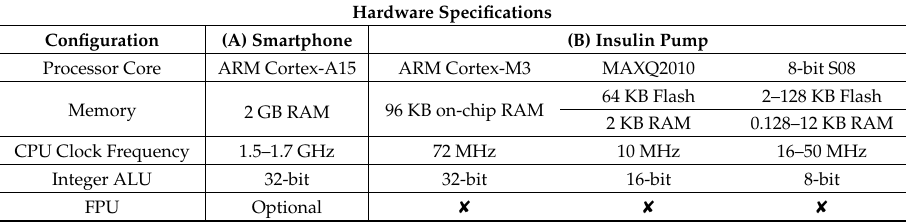
Table 1. Hardware specifications for various AP (artificial pancreas) configurations. Comparison metrics include: processing unit, memory capability, clock frequency, arithmetic logic unit (ALU) and availability of floating point units